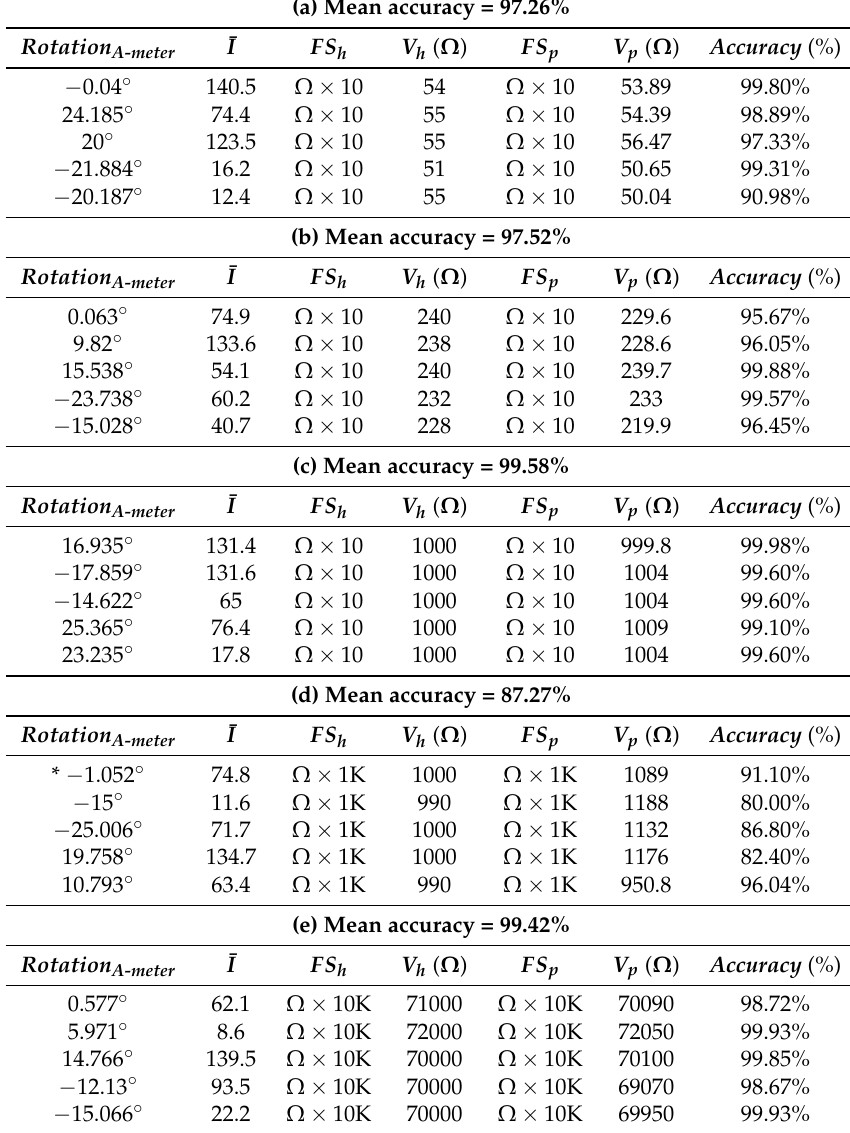
Table 8. Results of using the A-meter YF-370A with function select (a) “ Ω × 10” to measure the resistance of the 50 Ω resistor, (b) “ Ω × 10” to measure the resistance of the 220 Ω resistor, (c) “ Ω × 10” to measure the resistance of the 1 K Ω resistor, (d) “ Ω × 1K” to measure the resistance of the 1 K Ω resistor, and (e) “ Ω × 10 K” to measure the resistance of the 70 K Ω resistor. (a) Mean accuracy =